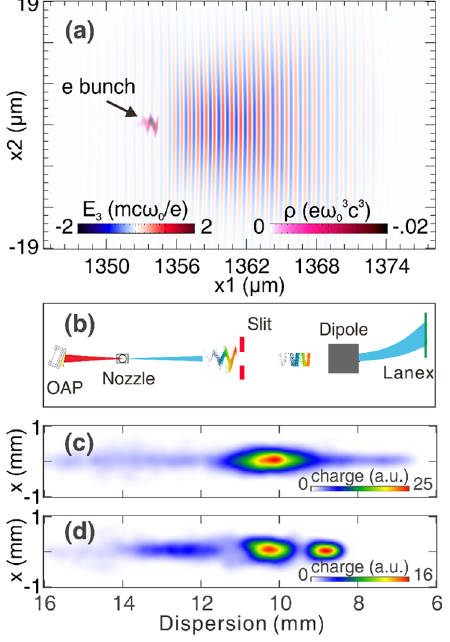
FIG. 1. Output of a synthetic numerical experiment from OSIRIS simulation. (a) Conceptual illustration of the electron bunch interacting with the back of the laser pulse (the plasma is not shown for clarity). (b) Schematic of the virtual energy spectrometer with slit which is similar to the experimental set up. The energy spectrums recorded by a virtual screen as seen without (c) and with the slit (d), respectively. The color scales are different in (c) and